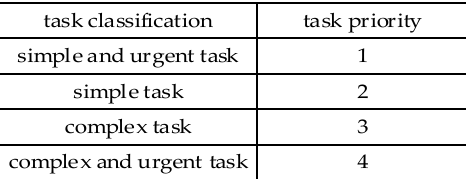
Figure 6. Task classification and corresponding priority.